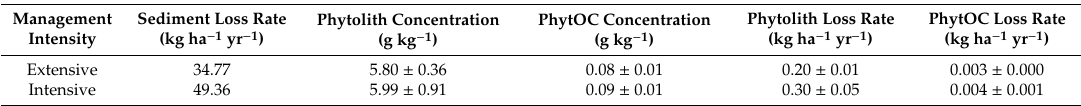
Table 3. Phytolith and PhytOC concentration in sediment, and sediment, phytolith and PhytOC loss rate (means ± standard deviations) under P. pubescens stands with different management intensities ( n = 3).